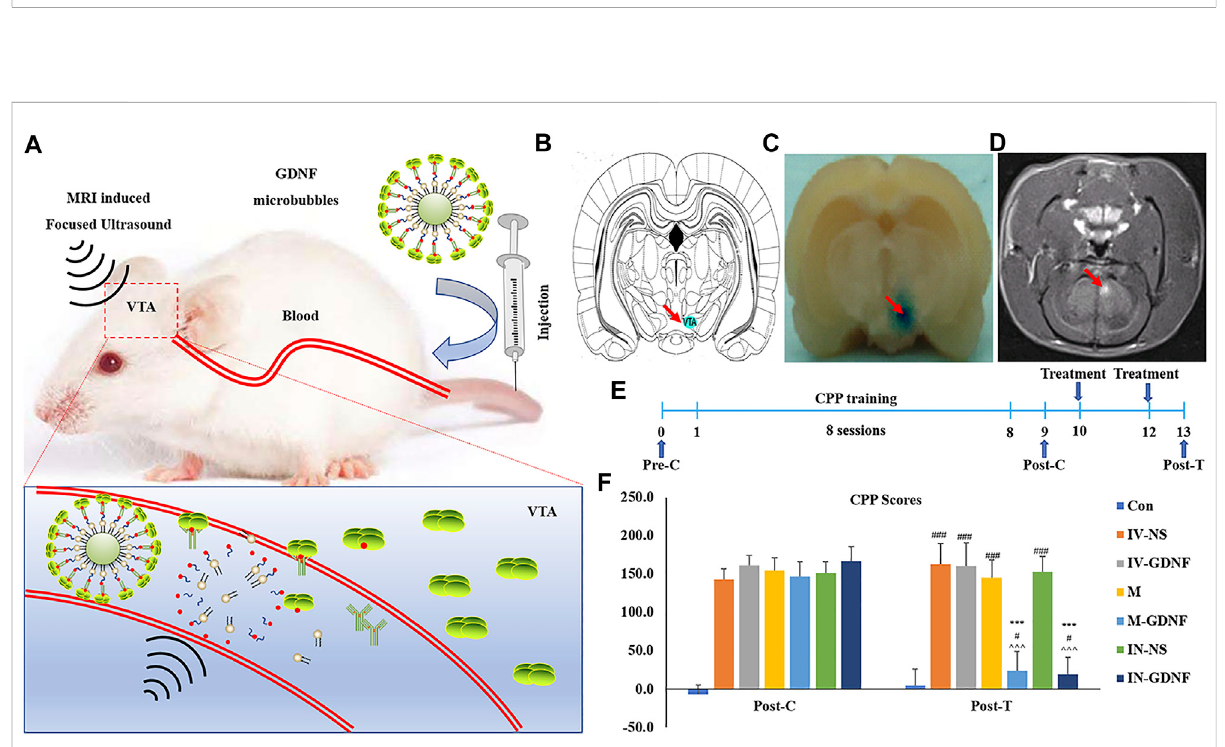
FIGURE 3 Focused ultrasound combined with GDNF-loaded MBs reversed morphine-induced CPP in rats. (A) Schematic diagram of targeted delivery of GDNF to VTAviafocused ultrasound combined with MBs. (B) Schematicrepresentationsof VTA. (C) The location oftheBBBopening wascon fi rmed by EB staining of the affected area (arrows). (D) BBB opening was monitored by leakage of the MR contrast agent into the brain parenchyma on coronal(COR)MRimages(arrows). (E) Schematicdiagramofexperimentalprocess. (F) CPPscores.Means±SEM, n =8,*** p < 0.001vs .